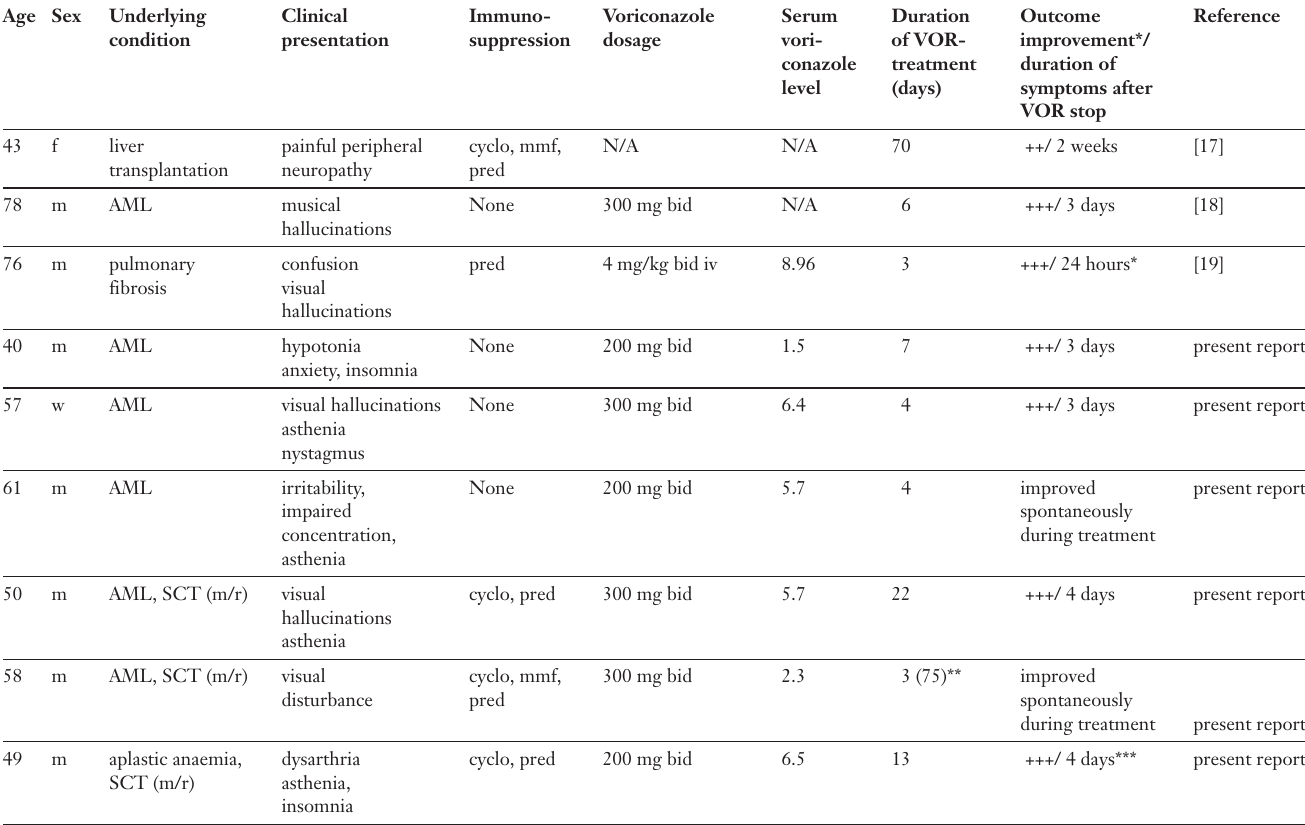
Characteristics of patients (six patients of the present study and 3 patients of previously published reports) with neurological adverse events during treatment with